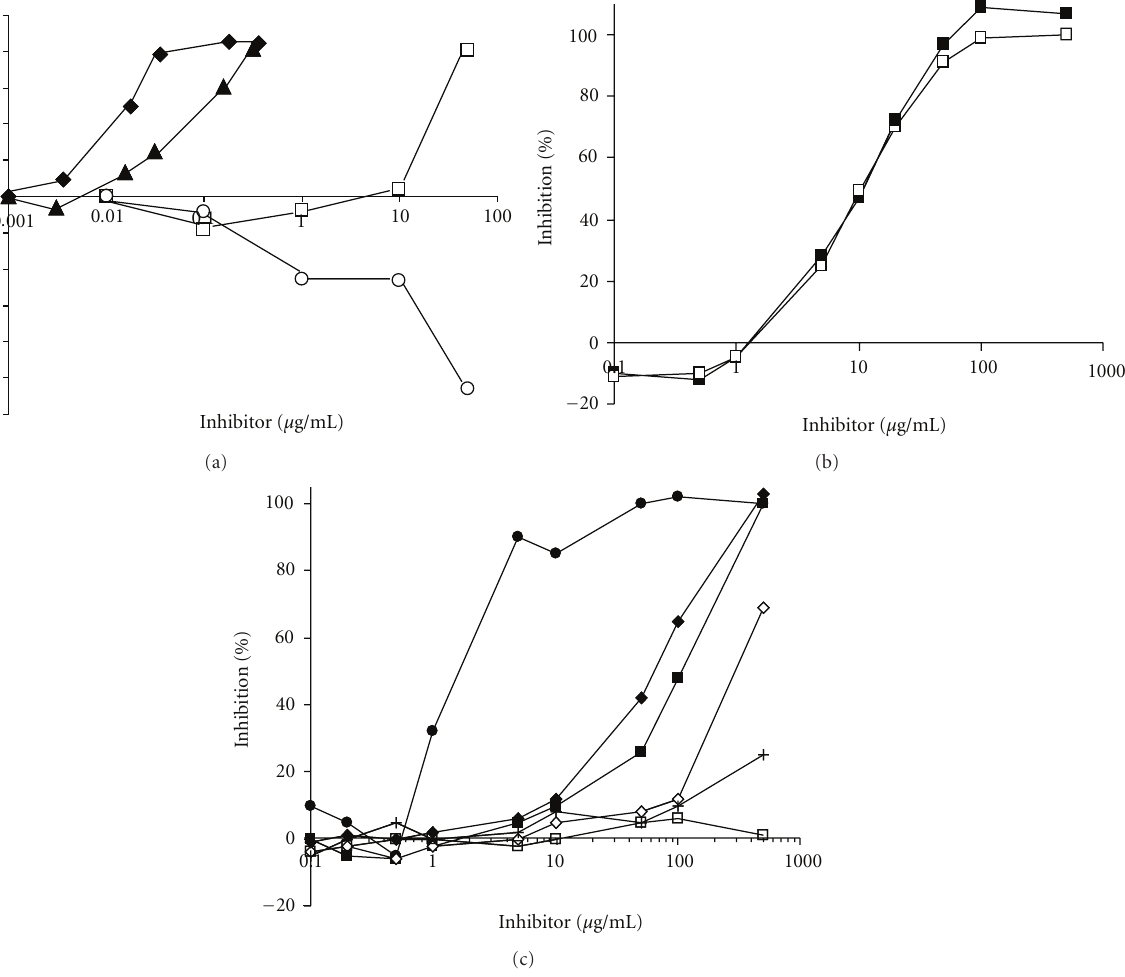
Figure 3: (a) Flavocoxid (0, 0.1, 1, 10, 50 μ g/mL) COX-1 ( ) and COX-2 ( (cid:5) ) cyclooxygenase (CO) inhibition versus indomethacin (0, (cid:0) 3.6, 18, 36, 180, 360 ng/mL, ) and NS-398 (0, 3.1, 15.7, 31.4, 157, 314 ng/mL, ). (b) Flavocoxid (0.1, 0.5, 1, 2, 5, 10, 50, 100, 500 μ g/mL) (cid:2) (cid:3) ) and COX-2 ( ) peroxidase (PO) inhibition. (c) Inhibition of 5-Lipoxygenase for phenidone ( • ), baicalin ( COX-1 ( (cid:4) (cid:0) catechin ( (cid:6) ), ibuprofen (+), and celecoxib ( ) at 0.1, 0.2, 0.5, 1, 5, 10, 50, 100, 500 μ (cid:0)